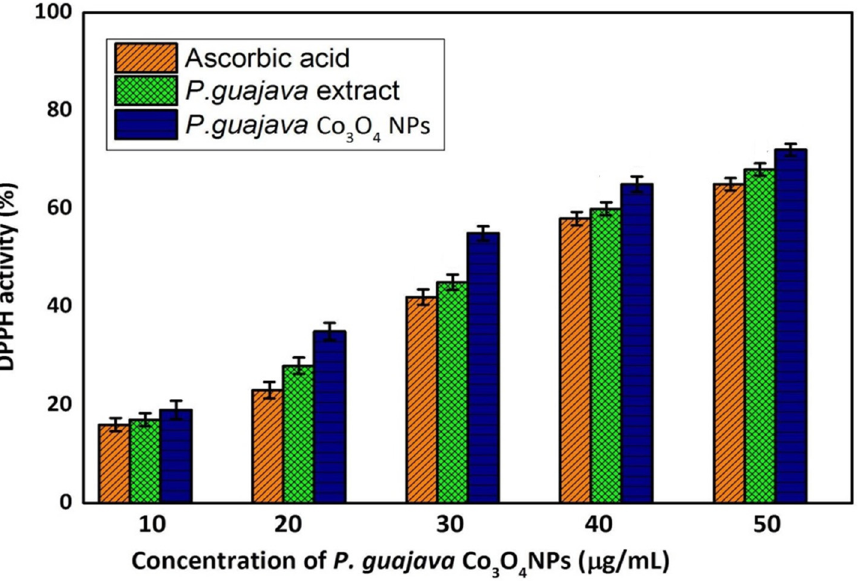
Figure 7. Antioxidant activity of Psidium guajava Co 3 O 4 NPs using DPPH assay. Results are repre- sented as mean ± SD, triplicate measures.